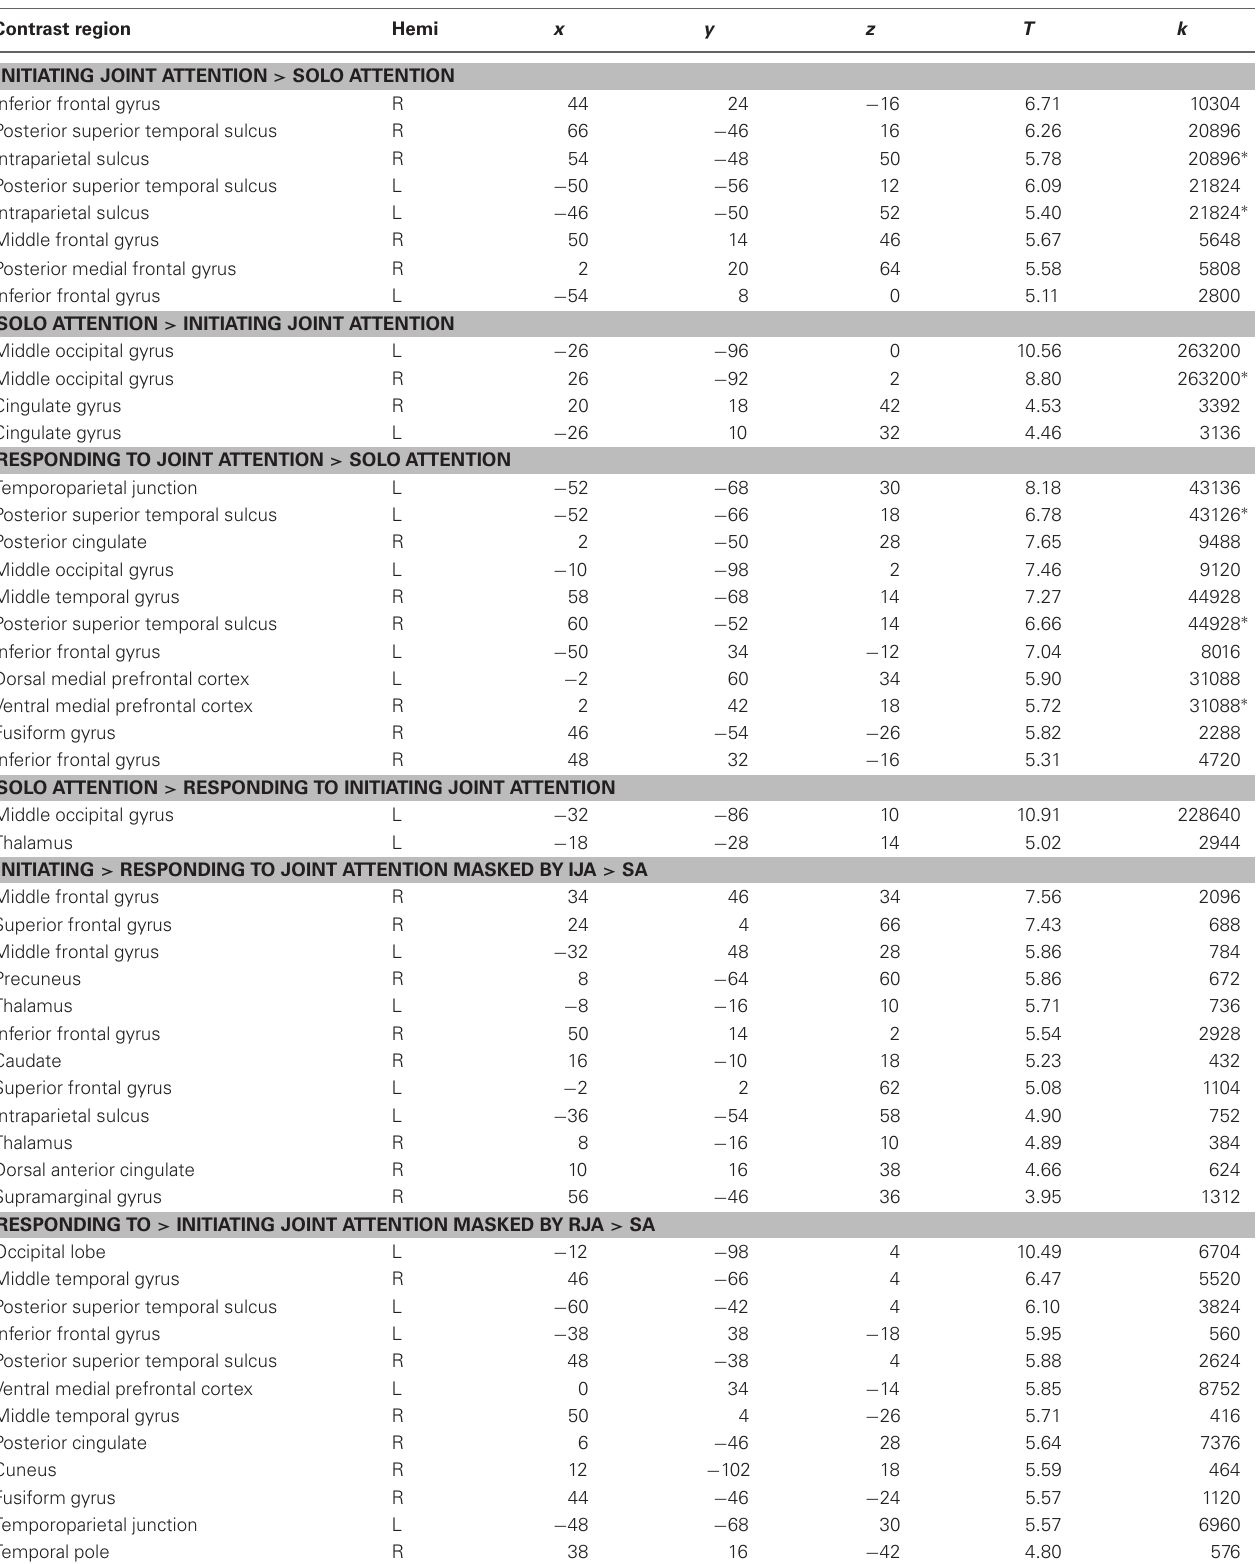
Table 1 | Comparisons between joint and solo attention